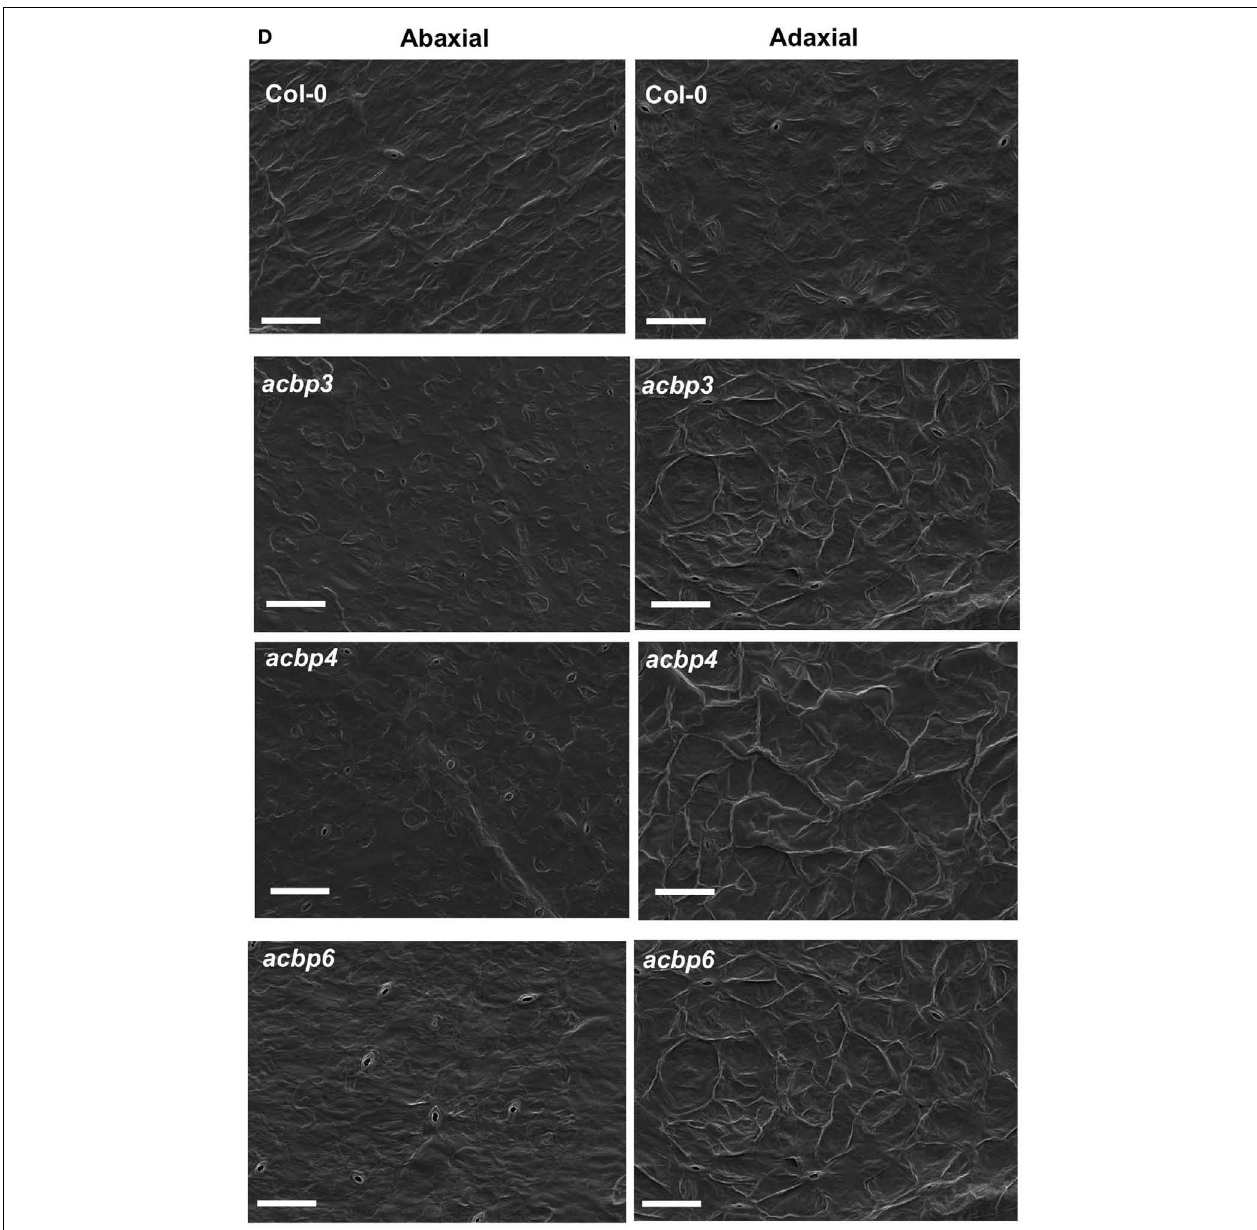
experiment was repeated three times with similar results. (C) Transmission electron micrographs showing cuticle layer on adaxial surface of leaves from indicated genotypes. At least two independent leaves were sectioned and analyzed. Arrows indicate cuticle. CW indicated cell wall (scale bars, 50nm). (D) Scanning electron micrographs showing adaxial (left panel) and abaxial (right panel) surface of leaves from indicated genotypes (scale bars, 200 µ M).Two-three independent leaves were analyzed per